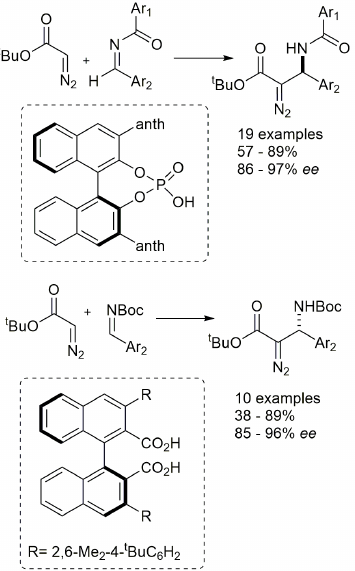
Figure 53 - Asymmetric coupling reaction of diazoketoesters with imines.